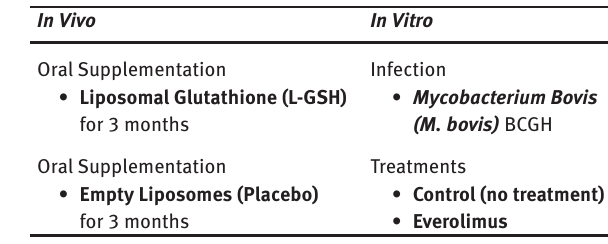
Table 1: In Vivo vs. In Vitro Study Components. The in vivo components of this study include the clinical intervention of either oral liposomal glutathione (L-GSH) or the placebo (empty liposomes) supplementation for three months in the T2DM subjects. Blood was drawn from study subjects in each the L-GSH and placebo arm to conduct in vitro studies on isolated PBMCS from the whole blood. The in vitro study components include an in vitro infection with M. bovis BCG strain and a one-time addition of everolimus at 1nM, or an untreated